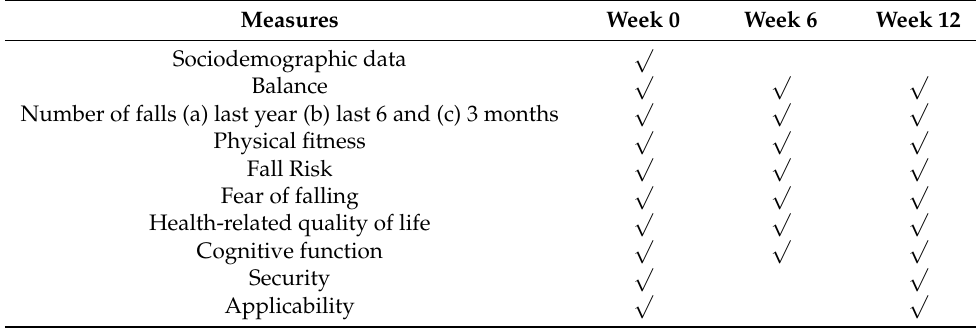
Table 2. Schedule of the evaluations in the experimental and control groups. Measures Week 0 Week 6 Week 12 √ Sociodemographic data Balance